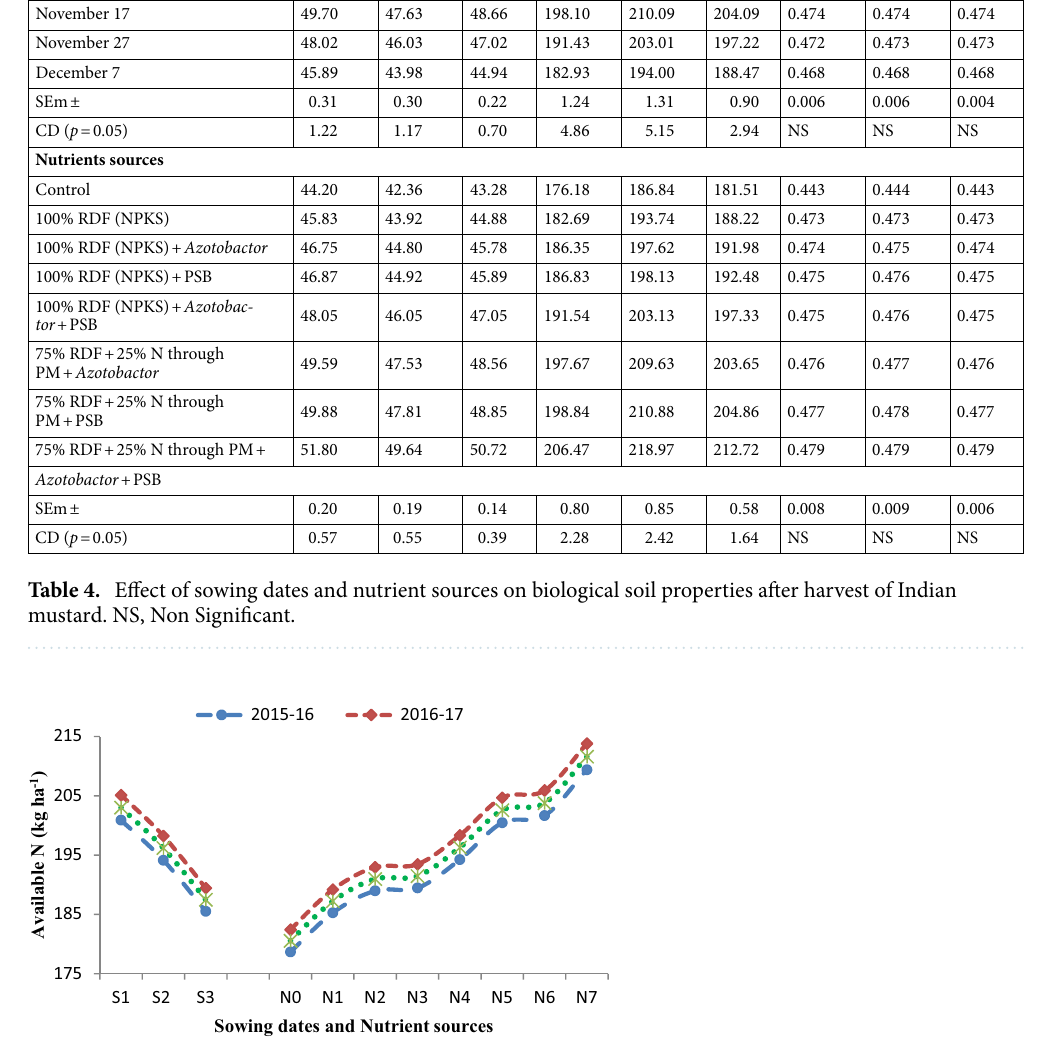
Figure 1. Effect of sowing dates and nutrient sources on available nitrogen (N) after the harvest of Indian mustard.